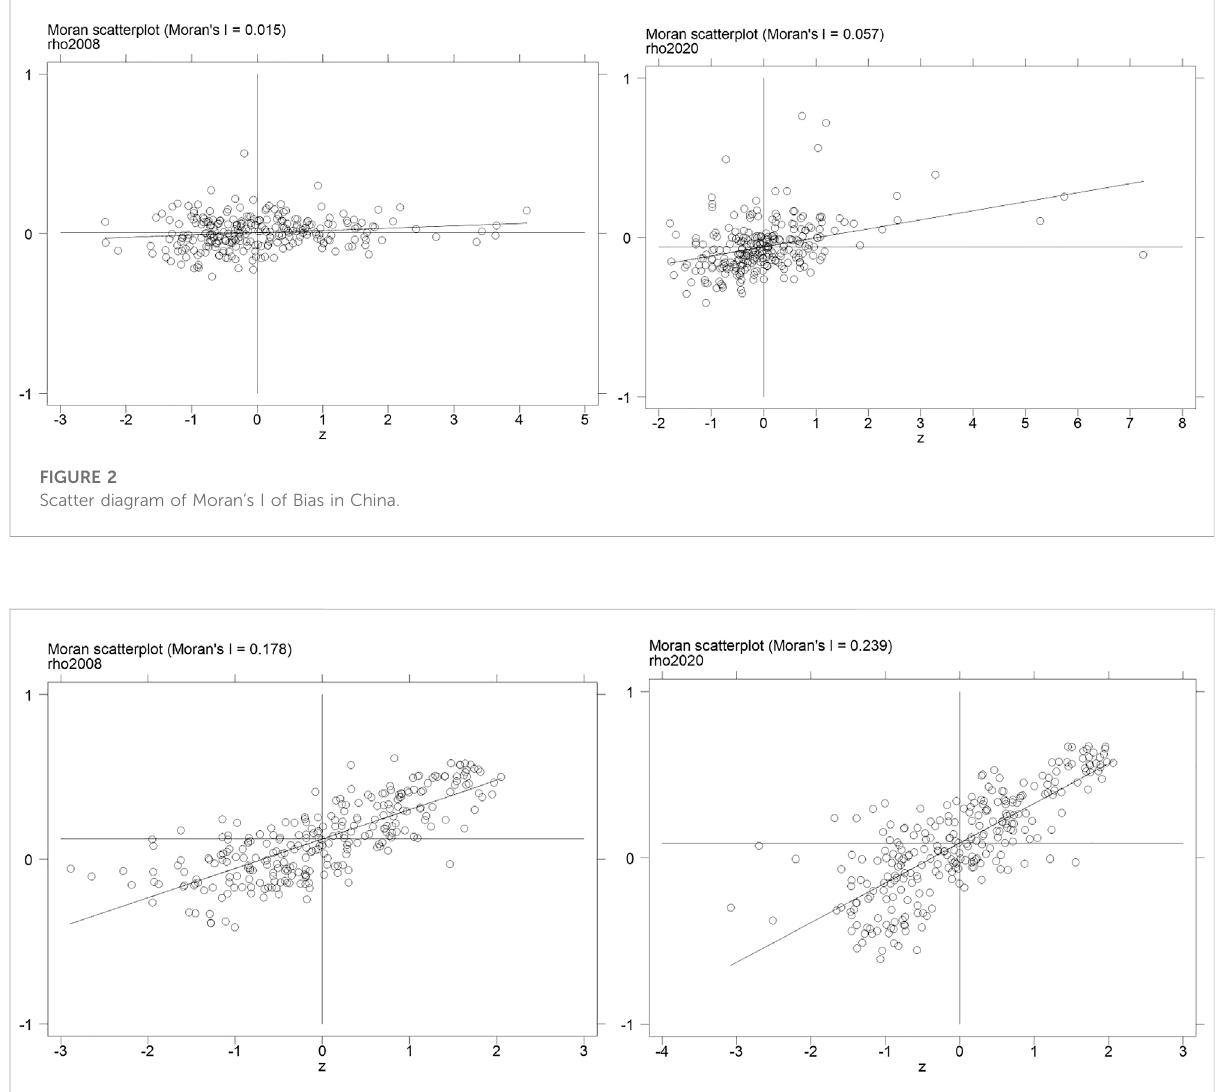
FIGURE 3 Scatter diagram of Moran ’ s I of PM2.5 in China.